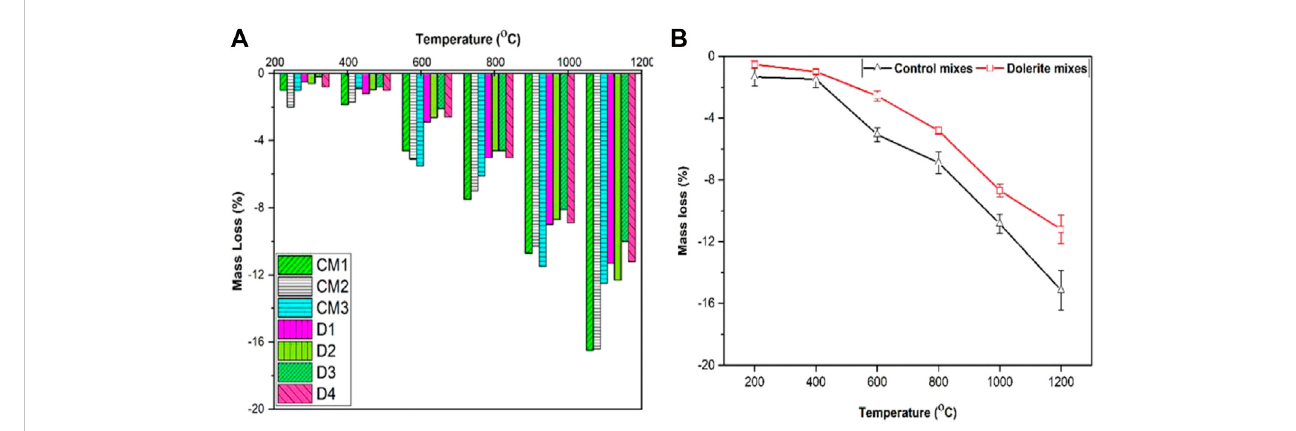
FIGURE 7 Mass loss of control and dolerite mixes as a function of temperature. (A) Mass loss (B) Mean and error as a function of temperature.